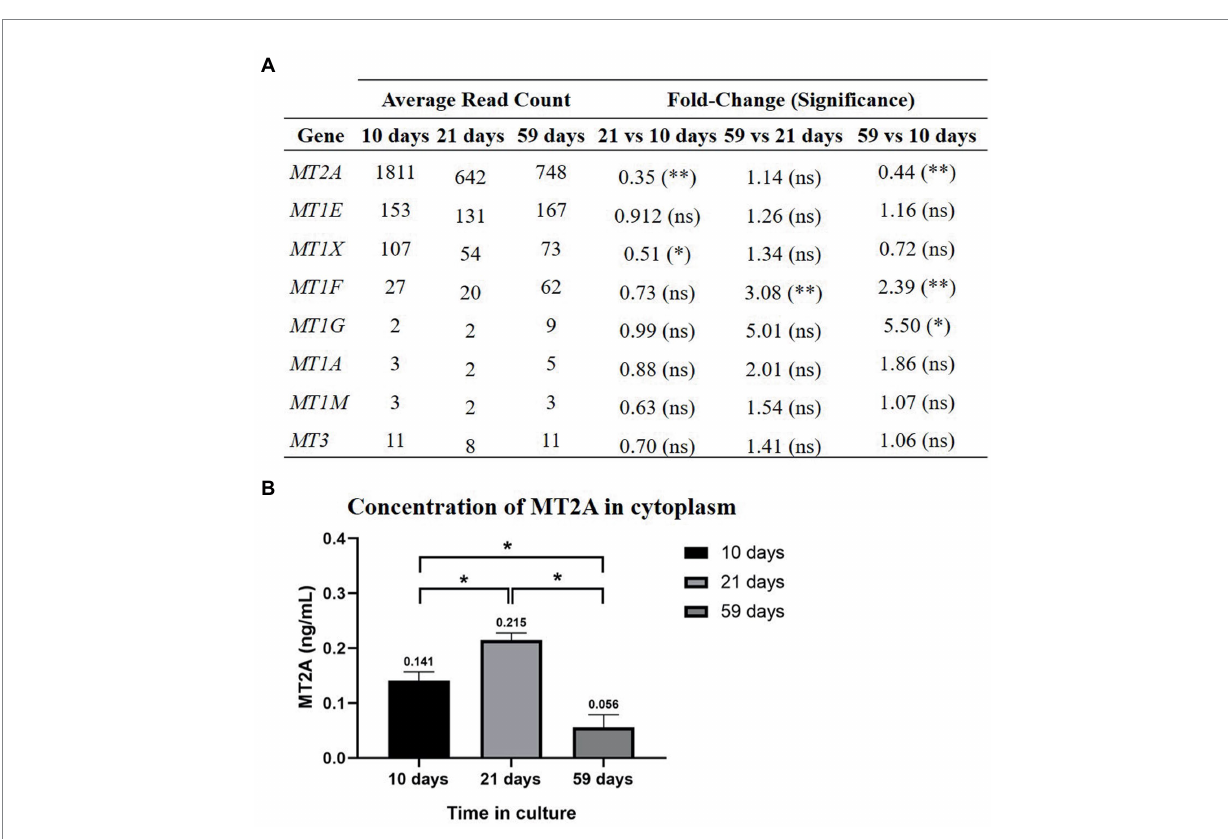
FIGURE 6 MTs gene expression in the RPE cell cultures at 10, 21, and 59 days (A) and MT2A protein concentration in the cytoplasm (B) . (A) At 59 days there was a downregulation of MT2A and upregulation of MT1F and MT1G. Differential gene expression analysis was carried out following the DESeq2 method (ns: q -value >0.05; *: q -value <0.05; **: q -value <0.01). (B) MT2A cytoplasmic concentration increases significantly from 10 to 21 days in culture and decreases from 21 to 59 days in culture. Data is represented as concentration (ng/mL) and error bars depict the standard deviation. *: significant p- value of two-way ANOVA (<